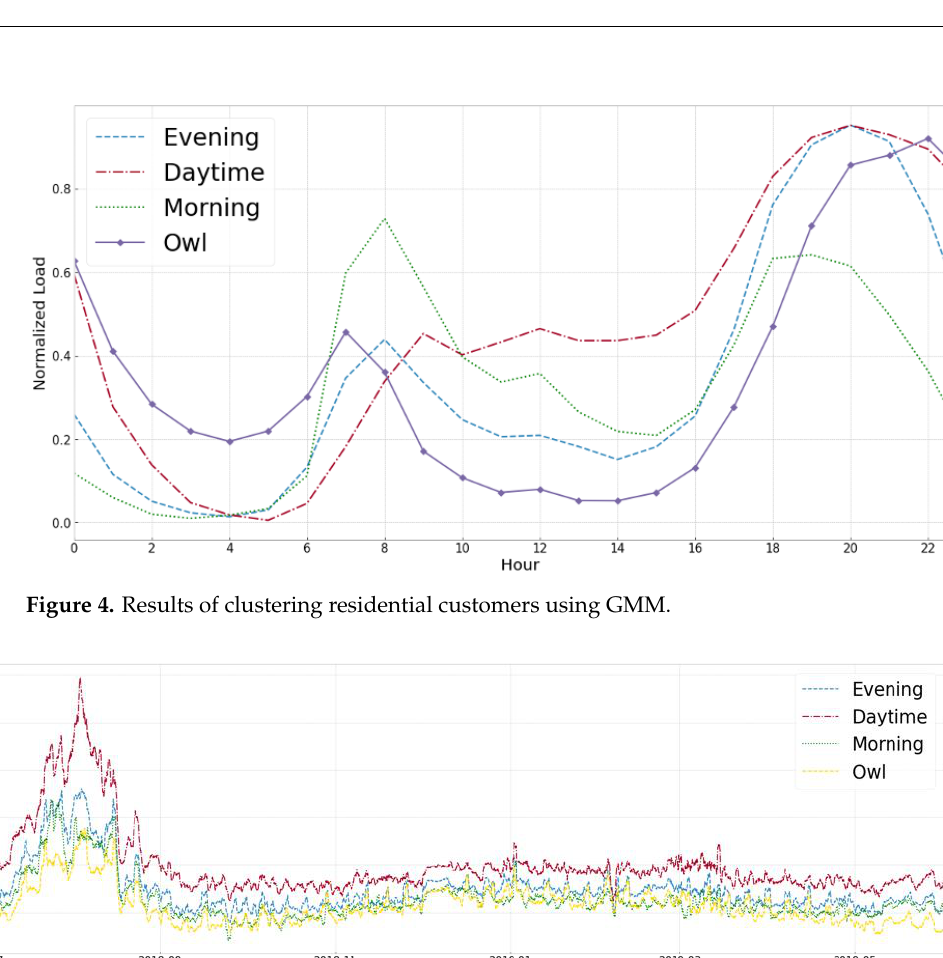
Figure 5. Annual load profiles for each group.